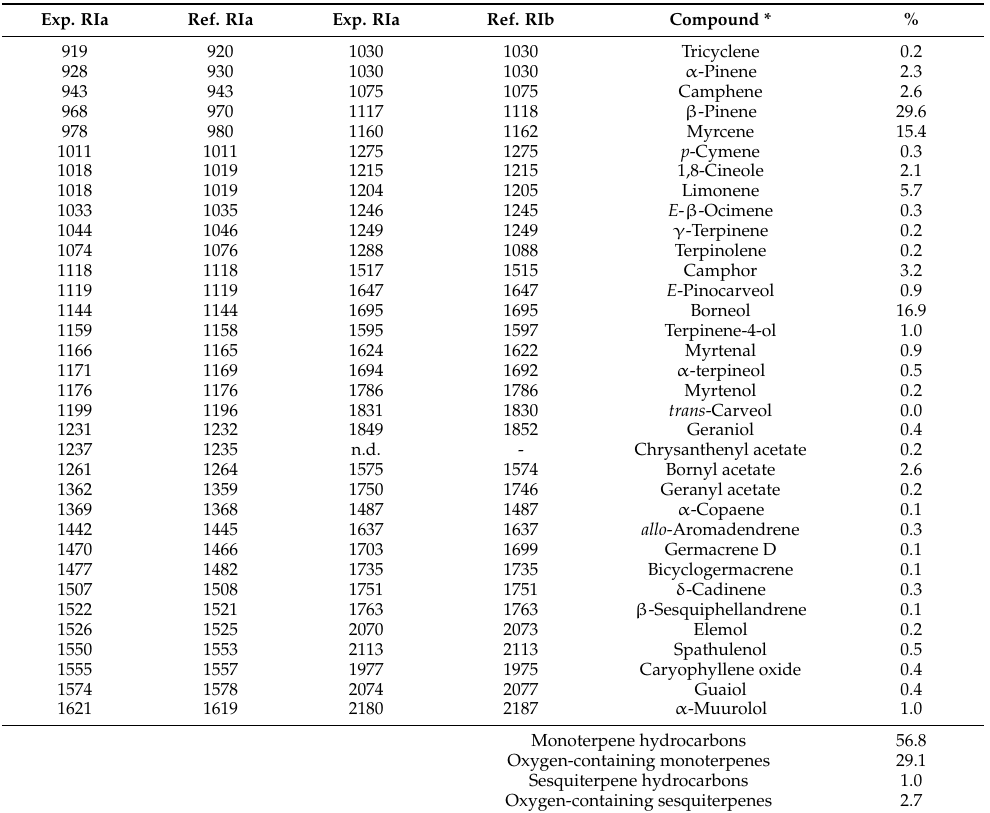
Table 1. Chemical composition of the essential oil of Santolina rosmarinifolia . Exp. RIa Ref. RIa Exp. RIa Ref.